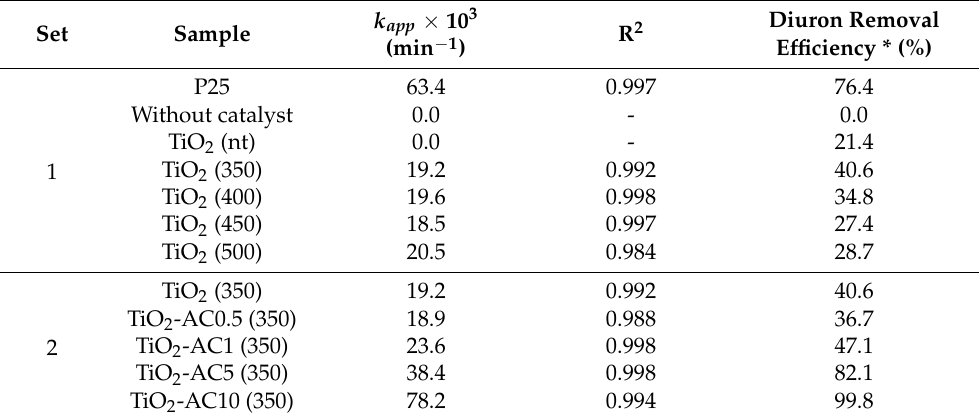
Table 2. Apparent first-order rate constant ( k app ) for diuron removal with the corresponding linear regression coefficients R 2 and diuron removal efficiency (%) in experiments shown in Figure 4. k app × 10 Set Sample